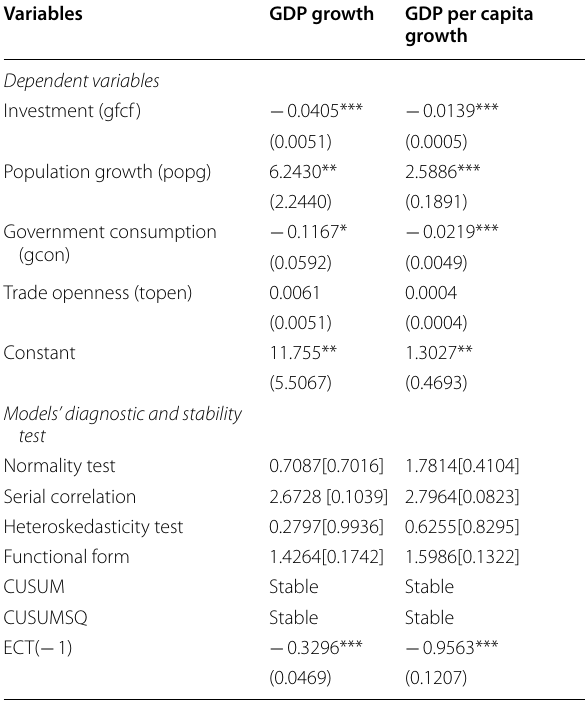
Table 5 ARDL long-run